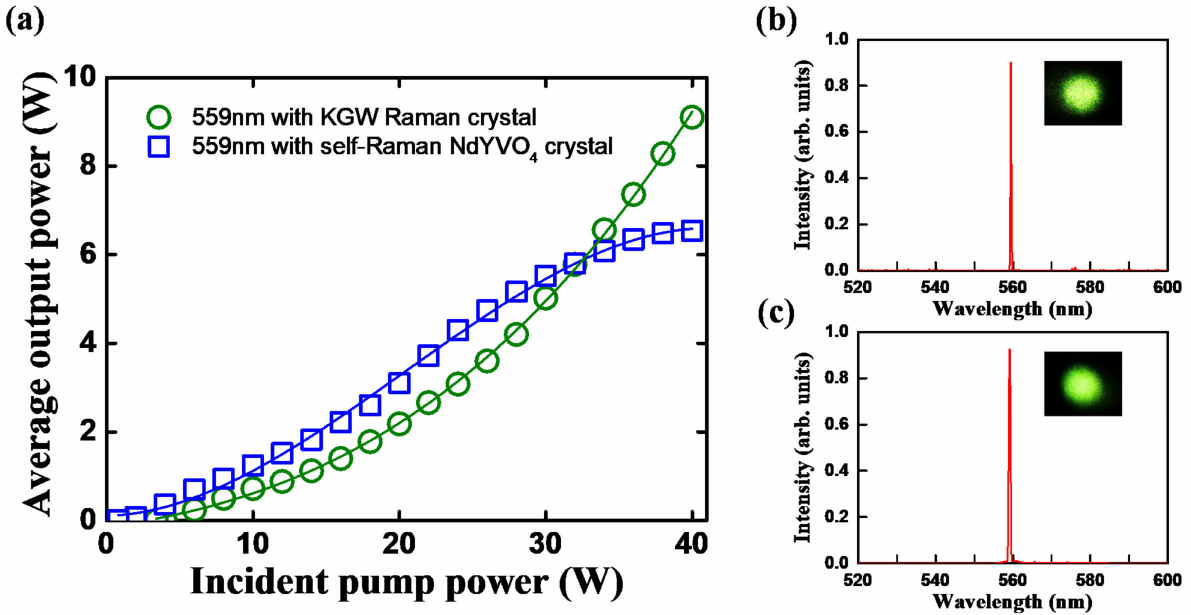
Figure 3. ( a ) The output power at 559 nm versus the incident pump power. Optical spectra of 559 nm wavelength and corresponding transverse mode patterns in the ( b ) self-Raman Nd:YVO 4 laser and ( c ) Nd:YVO 4 /KGW Raman